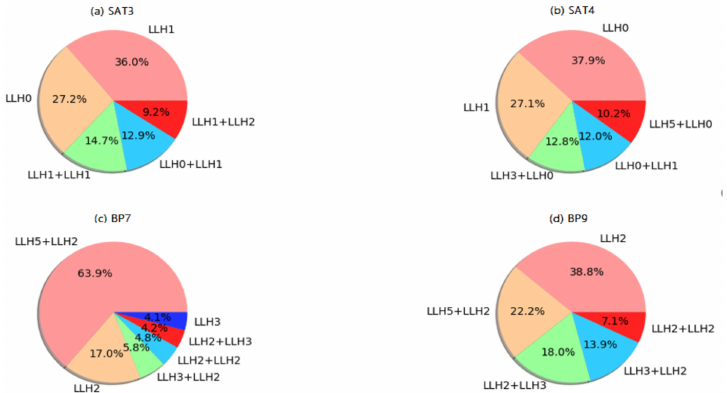
Figure 6. Analysis of two SAT and two BP instances.